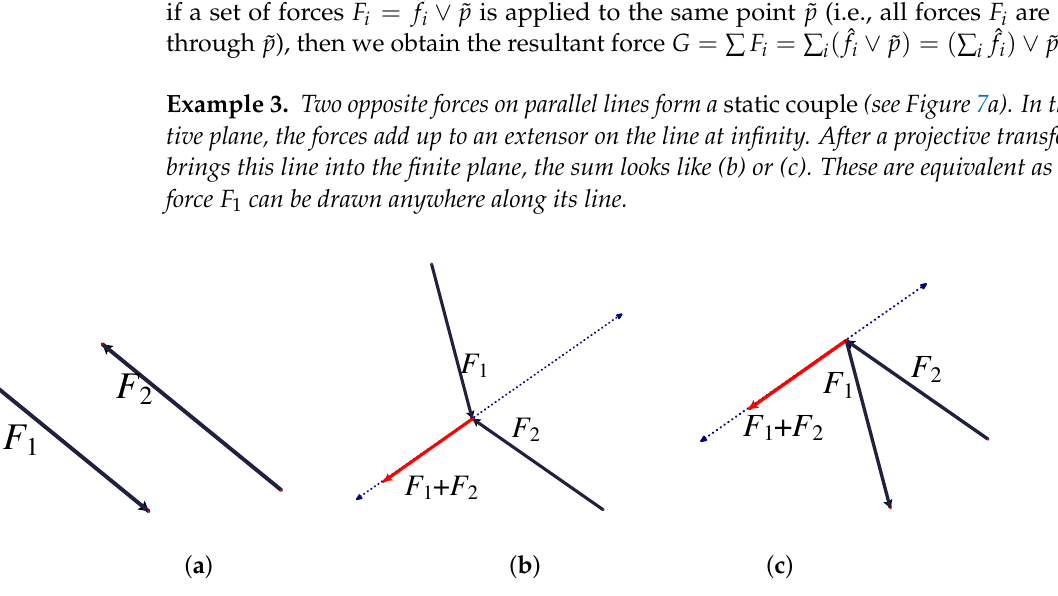
Figure 7. Two opposite forces on parallel lines ( a ) form a couple. They will add up to a force along the line at infinity. After a projective transformation, they appear as ( b ) or equivalently ( c